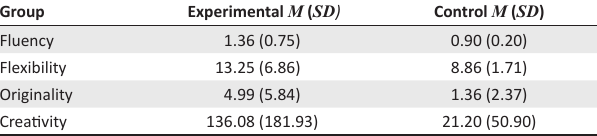
TABLE 4: Means and standard deviations for creativity scores after the Cognitive Research Trust programme ( N = 27 for the experimental group and N = 26 for the control group).